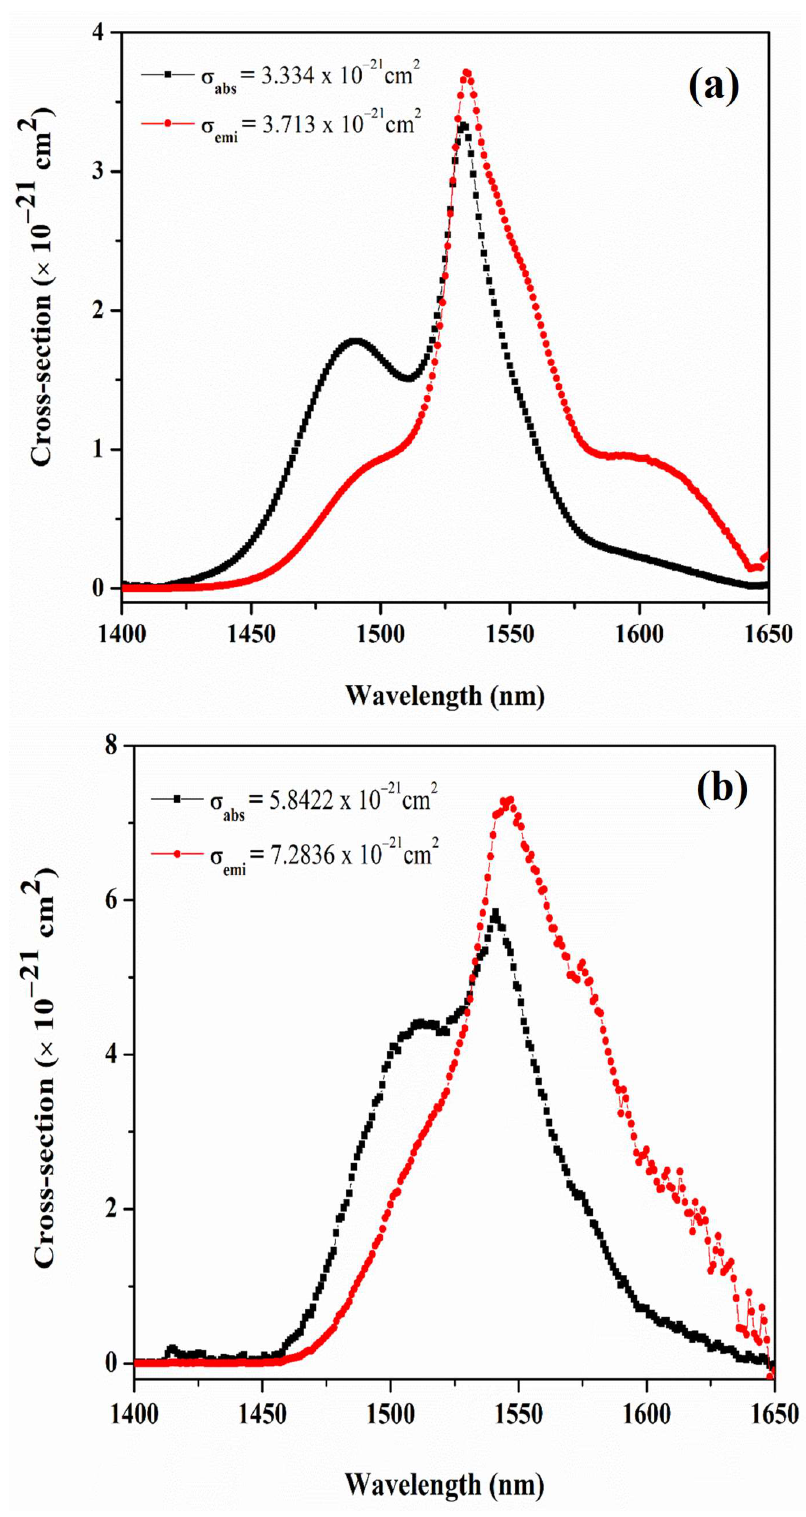
Figure 8. Absorption and emission cross ‒ section of 0.5Er doped ( a ) and 0.5Er2.0Yb co ‒ doped ( b ) ZBB glasses.